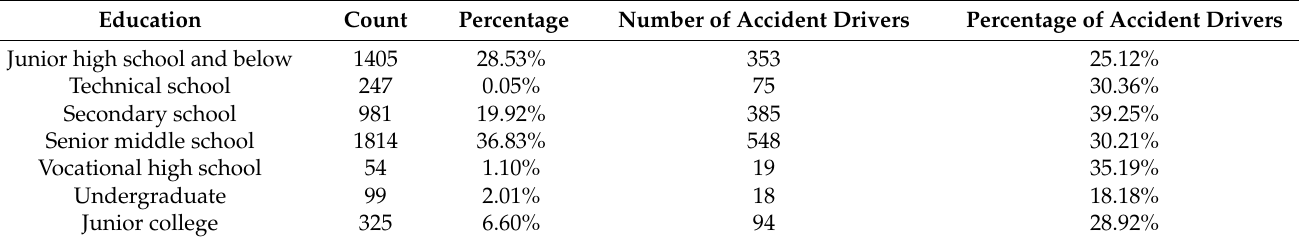
Table 8. Education